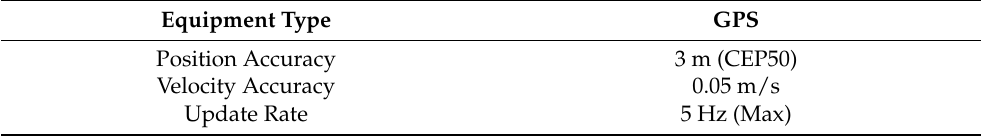
Table 1. Specification of GPS used on the AUV platform.